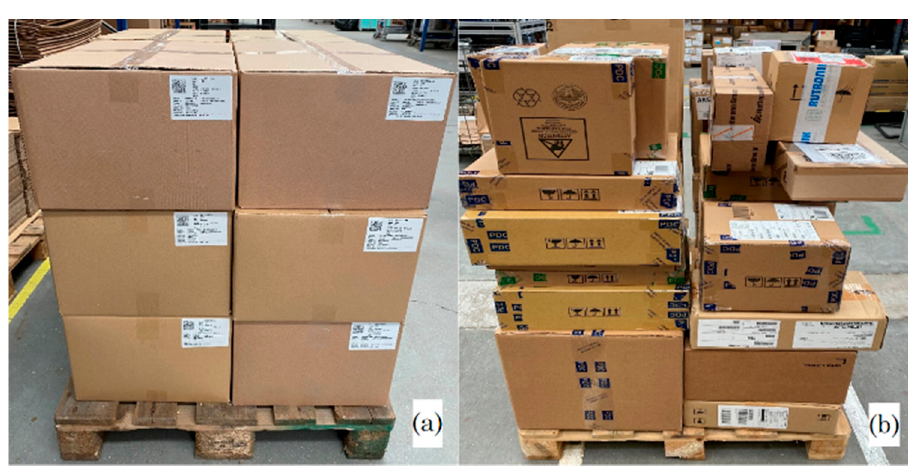
Figure 2. ( a ) Single Code pallet and ( b ) Multi Code pallet.